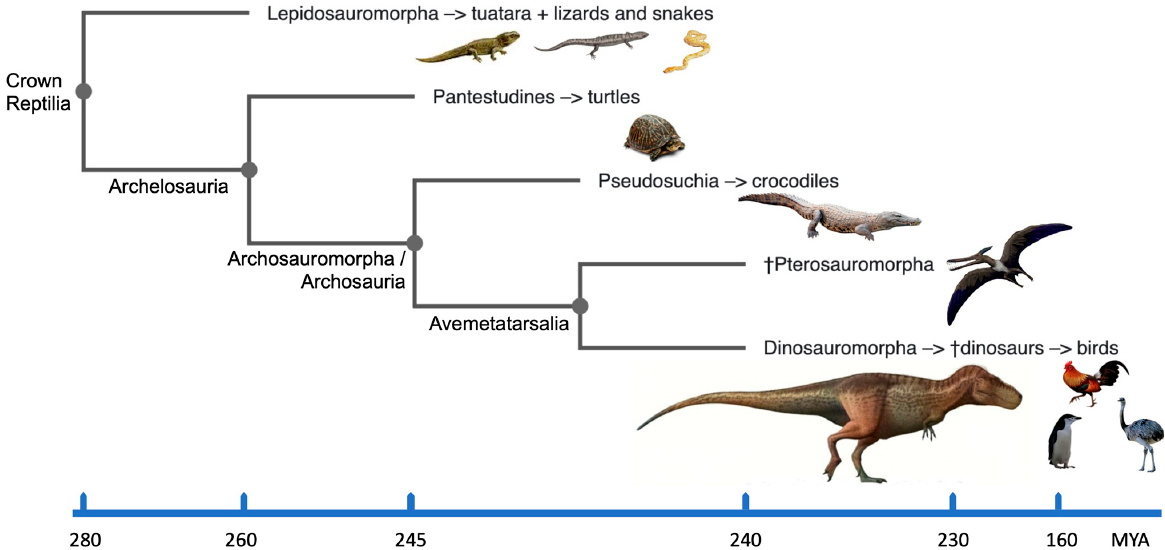
Figure 1. A simplified cladogram of the crown group Reptilia for major evolutionary groups including dinosaurs, birds and reptiles, based on [22–24] and plotted using the Phylo.io webtool [25]. † extinct groups. Time scale is not linear.